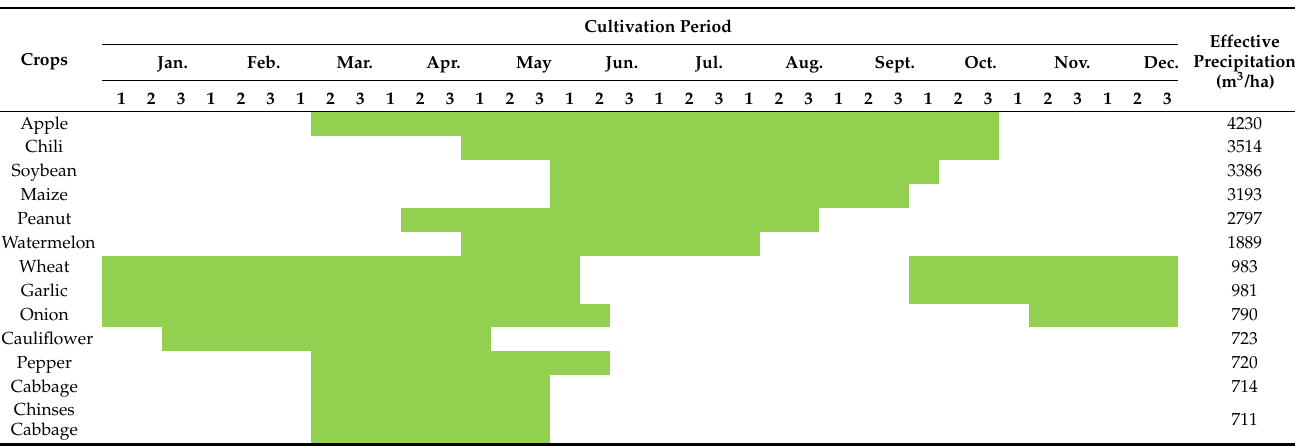
Table 3. Growth periods and effective precipitation of different crops. Numbers 1, 2, and 3 represent the first, second, and third ten days in a month.